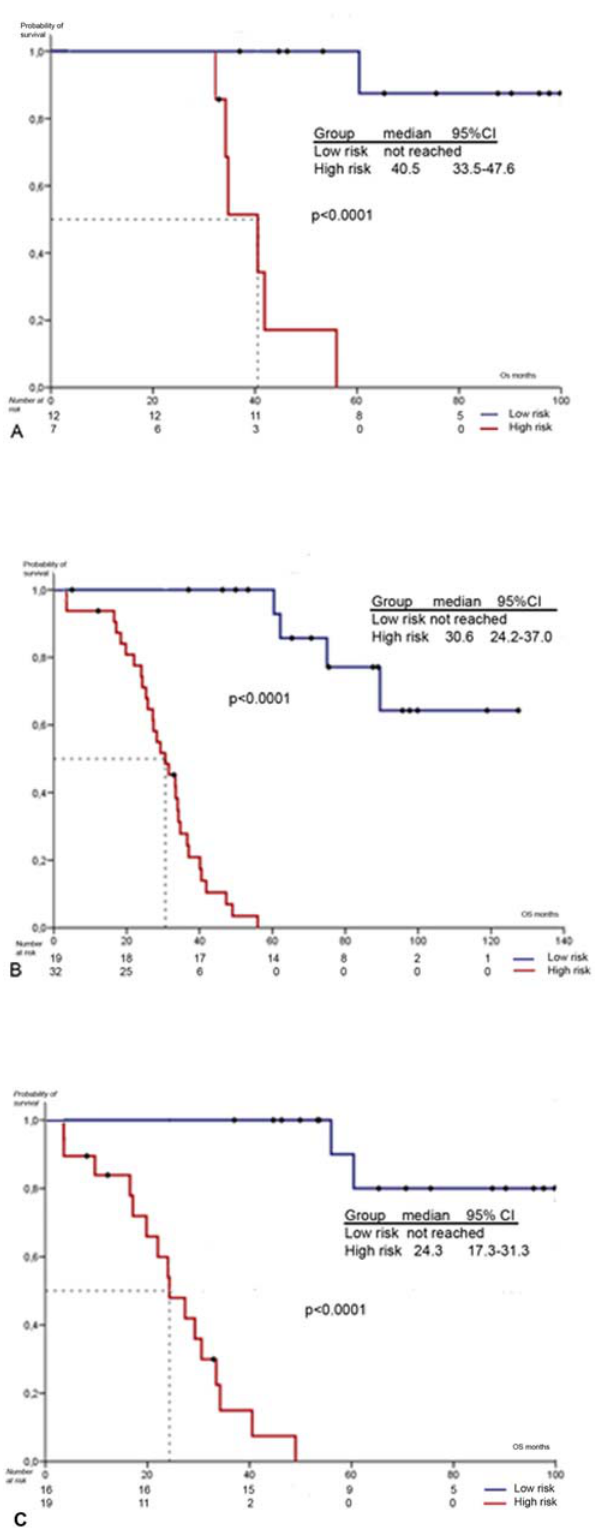
Figure 2. Kaplan-Meier OS curve (low risk versus high risk) in optimally debulked subgroup (A), in FIGO stage III subgroup (B), and in differentiation grade 3 subgroup (C).